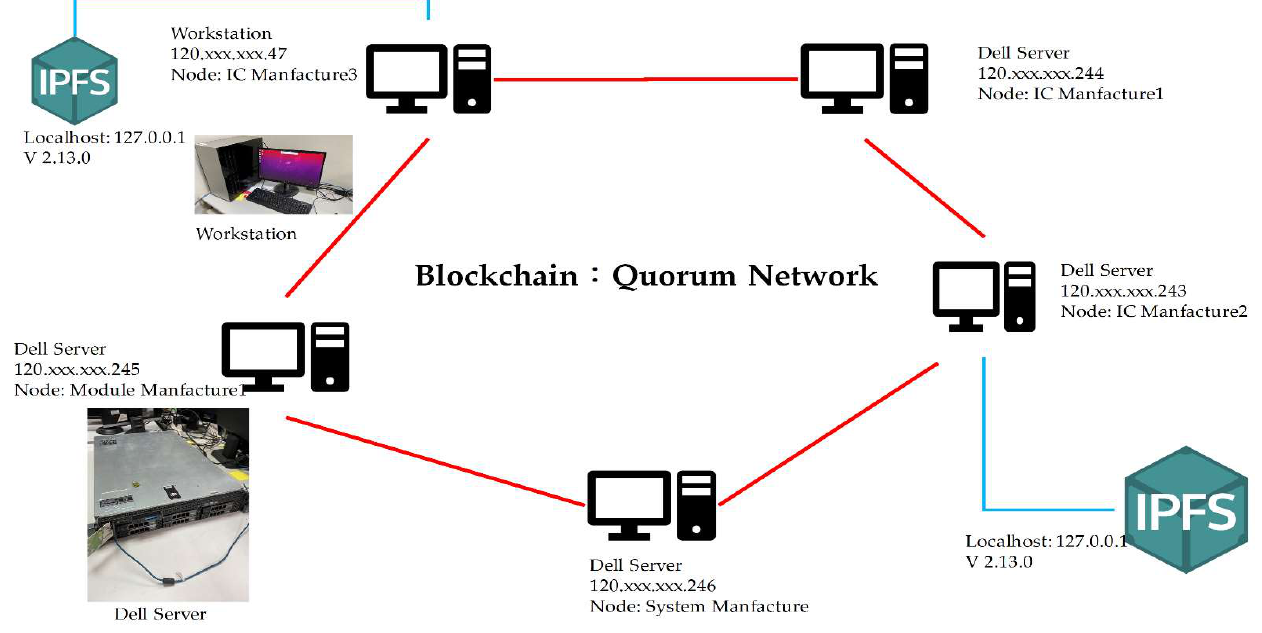
Figure 8. The PowerEdge R710-Dell server is applied to construct the consortium